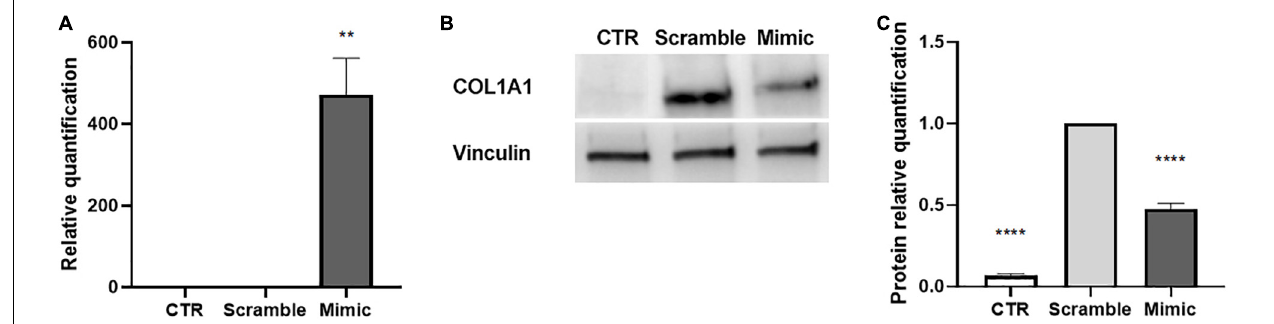
FIGURE 6 | Induction of miR-146a-5p in activated LX-2. (A) QRT-PCR validation of the induction miR-146a-5p expression in activated LX-2 after 24 h of transfection with miR-146a-5p mimic. MiRNA expression levels were normalized on those of miR-24-3p. (B,C) Representative images of western blot analysis (B) and protein bands quantification of COL1A1 (C) in activated LX-2 after 48 h of transfection with miR-146a-5p mimic. Protein bands intensity was normalized on vinculin expression. For all experiments, LX-2 activated with TGF- β 1 (10 ng/mL) and transfected with a negative control mimic (scramble) were used as reference control. LX-2 cultured without TGF- β 1 were used as negative control (CTR). Statistical analysis was performed on results obtained from three independent experiments using the One-way ANOVA test: ** p < 0.01; **** p < 0.0001.